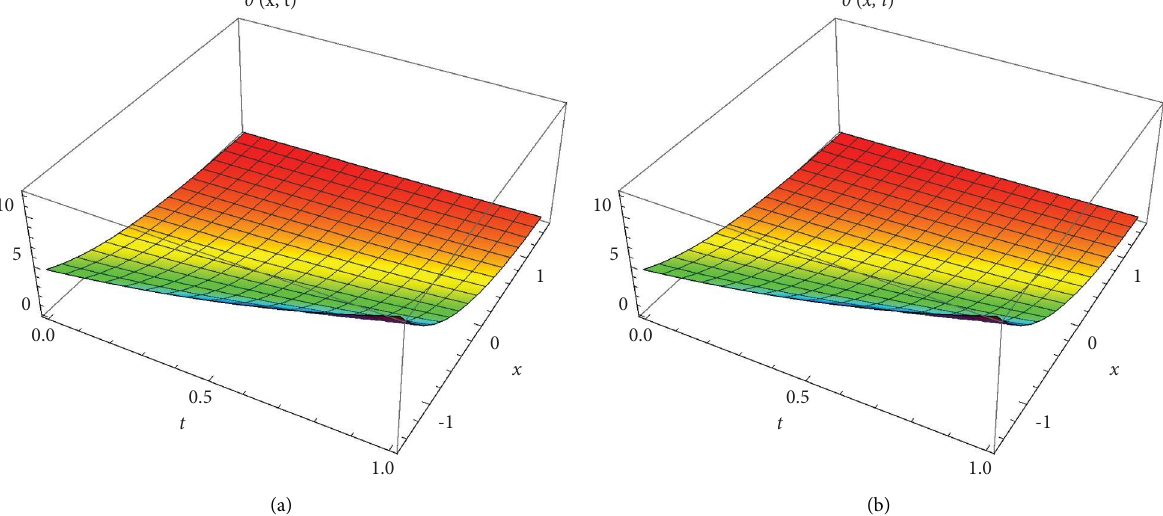
Figure 1: Te surfaces solution of gas dynamic equation. (a) Te approximate surface solution of ϑ ( x,t ) . (b) Te exact surface solution of ϑ ( x, t ) .